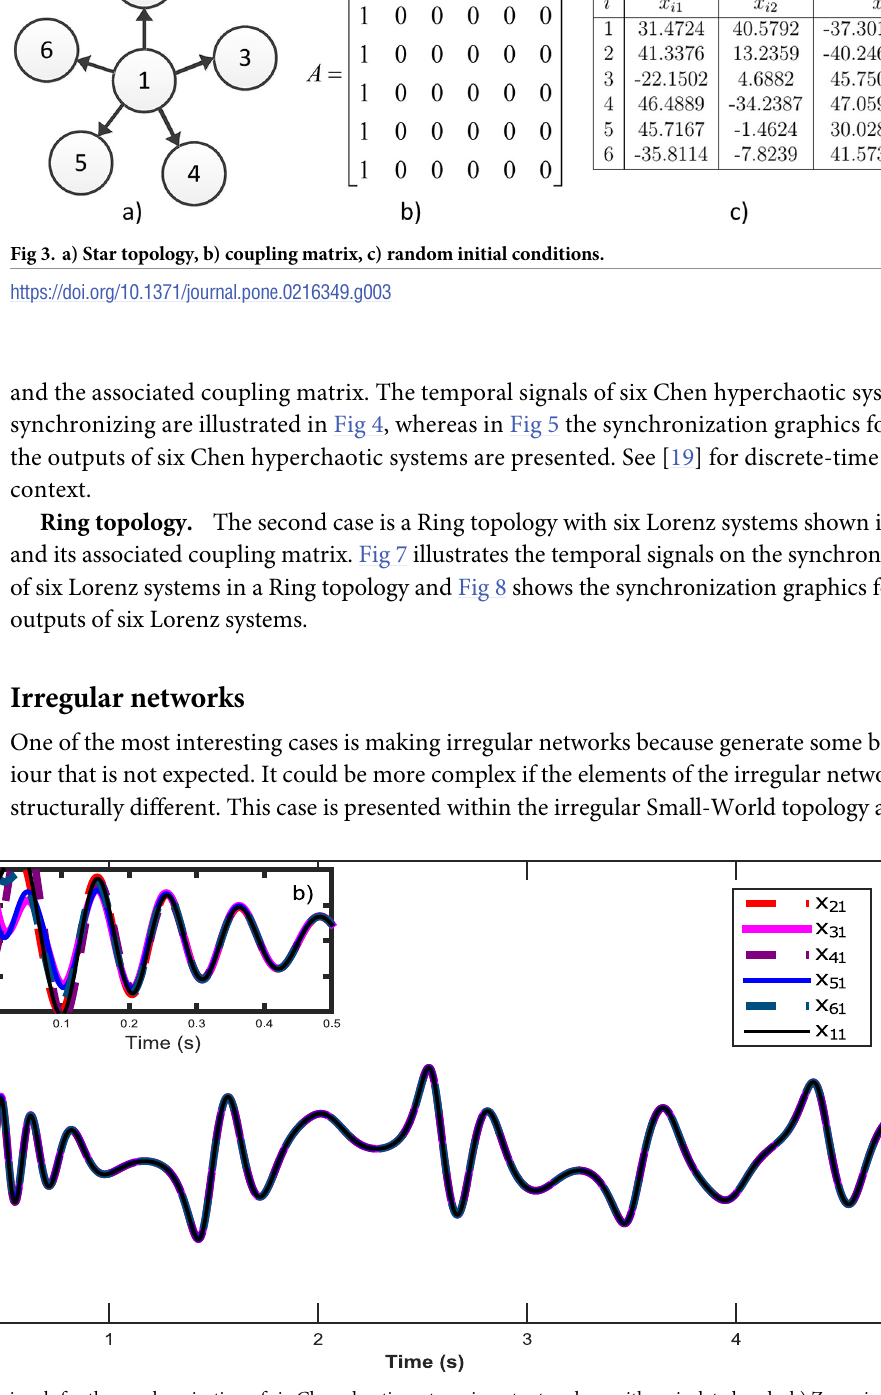
Fig 4. a) Temporal signals for the synchronization of six Chen chaotic systems in a star topology with an isolated node. b) Zoom in window showing the convergence in time for all x i 1